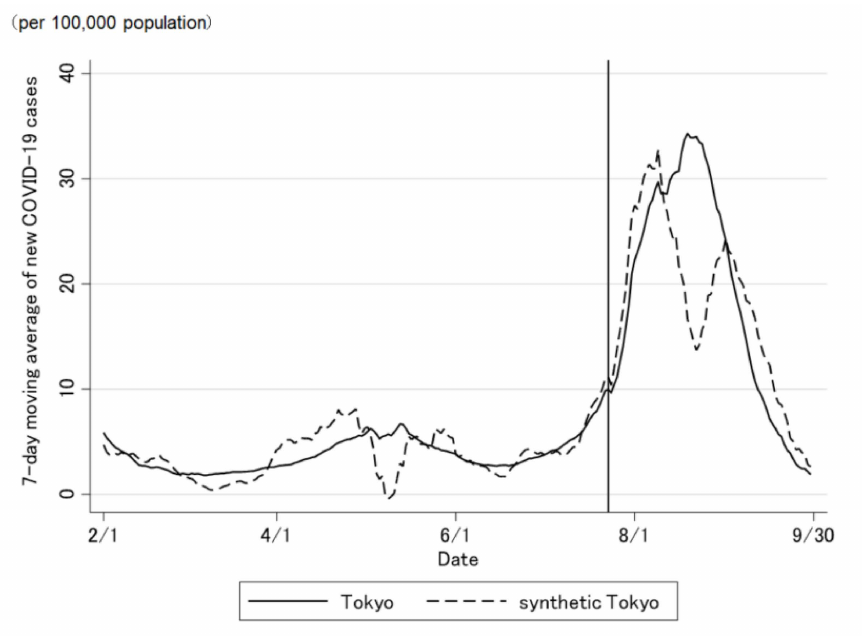
Figure 6. Trends of the daily number of newly confirmed COVID-19 cases in Tokyo and synthetic Tokyo, determined using regression weights.